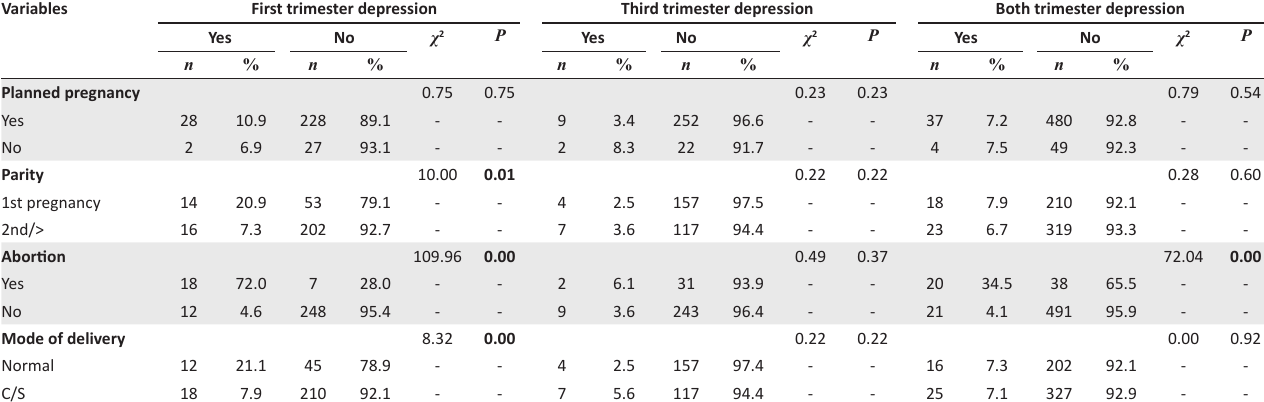
TABLE 5: Relationship between depression and obstetrics/gynaecological variables. Variables